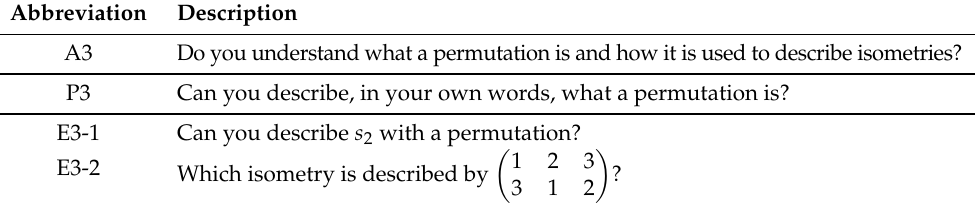
Table A3. Overview and descriptions for all units included in the interview regarding key idea 3 ( Permutations , cf. Table 1). A stands for acceptance, P for paraphrasing, and E for